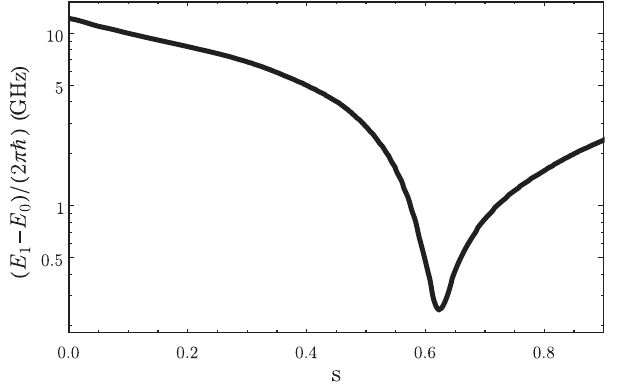
FIG. 5. Gap of the quantum Hamiltonian for h 1 ¼ 0 . 44 as a function of the annealing parameter. The solid line is the energy difference between the ground state and the first excited state. The 0 . 62 corresponds to a minimum gap avoided crossing at t=T QA ¼ of 248 MHz. The next excited state is separated by a gap in excess FIG. 7. Logarithmic plots of the theoretically modeled tran- of 2 GHz. sition rate W 10 ð s Þ versus s after the avoided crossing for different temperatures. Red, green, mustard, and blue correspond to T ¼ 12 , 8, 6, and 4 mK, respectively. All plots correspond to